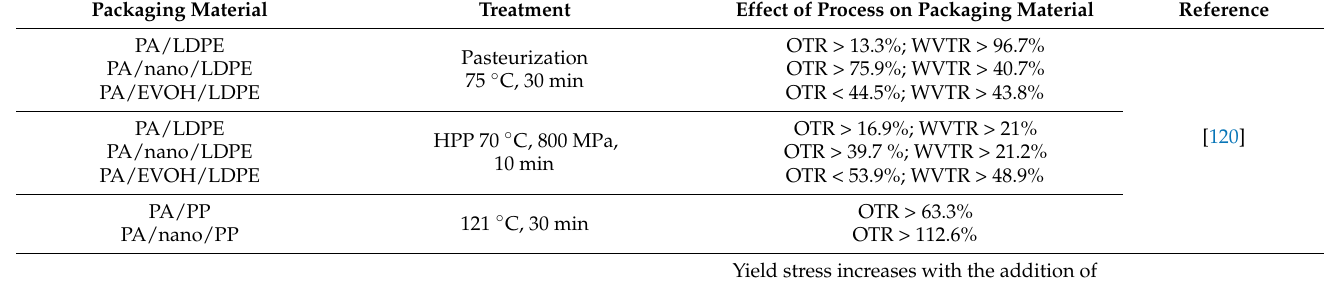
Table 2. Effect of non-thermal treatments on nano-packaging material